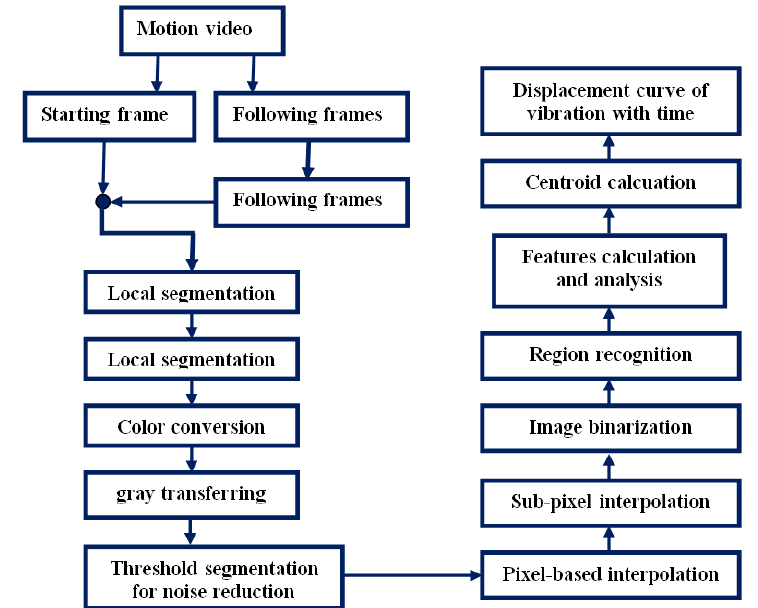
Fig.2 algorithm flow chart of